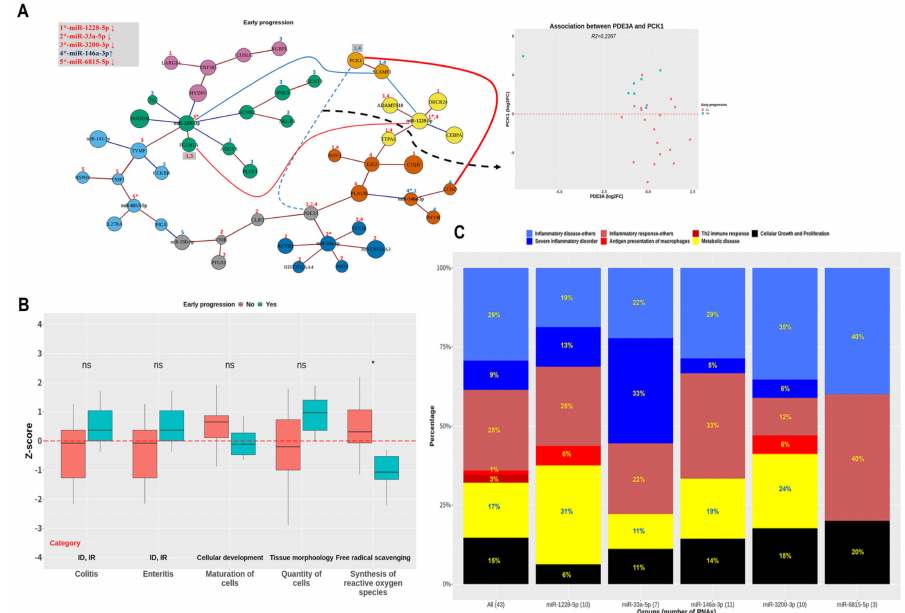
Figure 4. Simplified network of miRNA-mRNA interactions in early progression. ( A ) A simplified network is presented from 10 RNAs involved in the shortest pathway connecting 5 mRNAs and 45 RNAs within four functional categories related to early progression. RNAs altered by the five main miRNAs are displayed by number(s) above vertices in red (downregulation) or blue (upregulation), and in bold ( p < 0.05) or plain ( p ≥ 0.05) fonts. Red and blue edges correspond to positive and negative correlations, respectively. ( B ) Subcategories are displayed to show the difference in Z-scores according to early progression; subcategories were selected based on significant Z-scores in all patients using the log 2 FC values of all 48 RNAs included in this network. Functional categories are defined below the boxplots as ID (inflammatory disease), and IR (inflammatory response). ns, p ≥ 0.05; *, p < 0.05. ( C ) Diseases and biological functions associated with the 43 RNAs and five groups formed by primary miRNAs in the network are shown using boxplots. Statistical analysis was performed using the Wilcoxon rank-sum test or Kruskal–Wallis test. Downregulation and upregulation of RNAs refer to log 2 FC < − 1.5 and log 2 FC > 1.5,